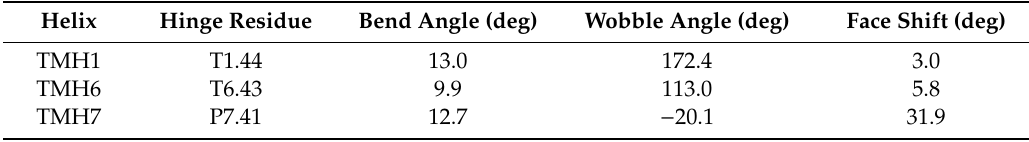
Table 1. ProKink analysis [36] results for the chosen TMH conformers for inclusion in GPR6